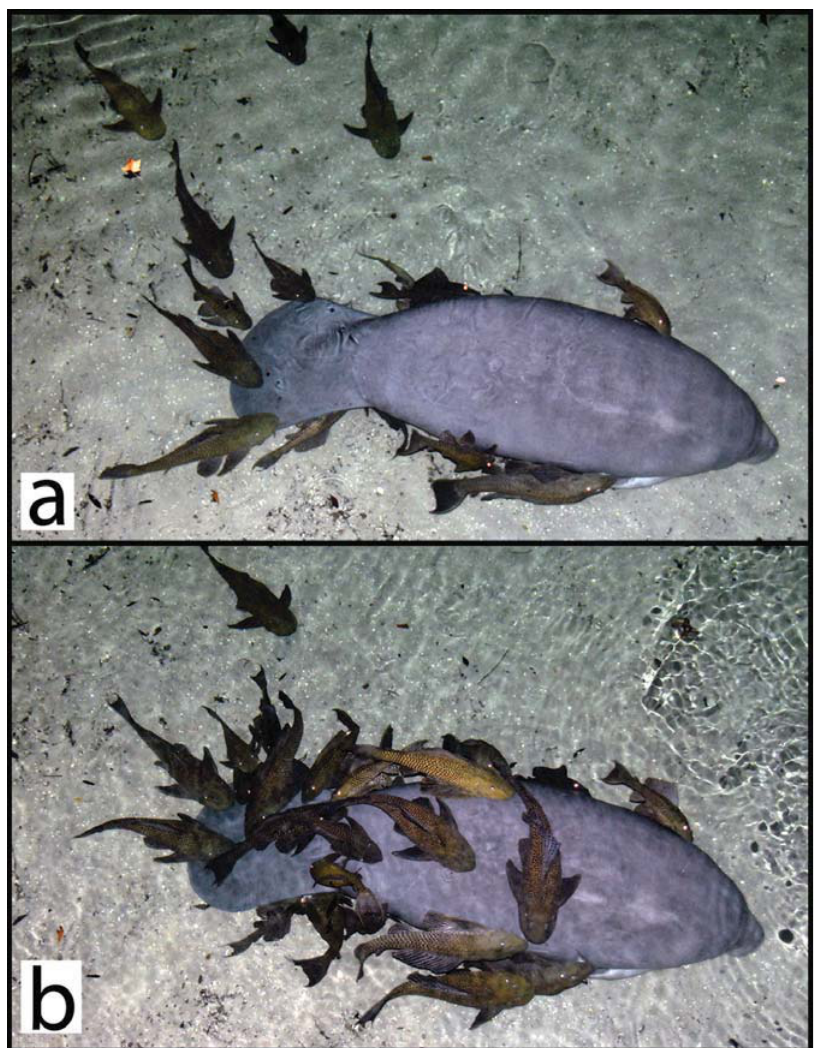
Fig. 1. Photographs showing nocturnal activity of adult and juvenile non-native Pterygoplichthys as evidenced by attachment on a resting Florida manatee ( Trichechus manatus latirostris ) yearling calf (about 1.3 m long), Volusia Blue Spring, Florida (11 December 2009). Photo a ) Time 4:21:16 h, catfish re-converging on manatee shortly after most had temporarily dispersed in response to presence of human observer. Photo b ) Time: 4:23:02 h, at least 20 catfish attached and additional individuals gathering around manatee; most of those attached are likely grazing on epibionts growing on mammal’s skin. Note eye shine of catfish resulting from camera flash. Photographs by Leo G.